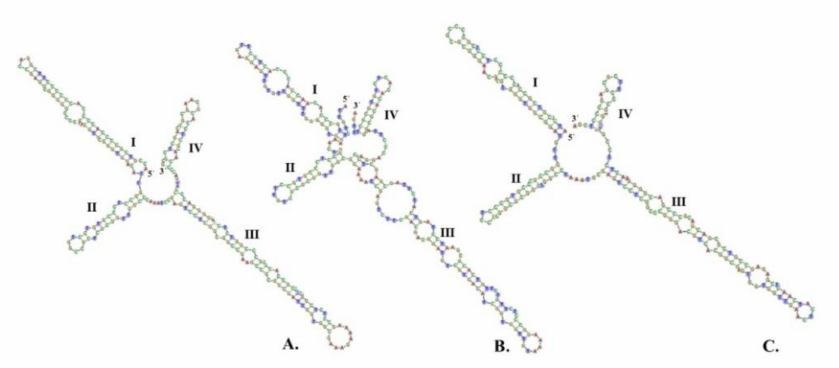
Figure 9. Predicted ITS2 secondary structure using Homology Modelling (HM) of ( A ) Aegle marmelos (L.) Corr ê a; ( B ) Coriander sativum L.; and ( C ) Morinda citrifolia L. as ingredients of the TS remedy. 2.6. Authentication of Crude Drugs of Aegle marmelos (L.) , Coriandrum sativum L. Corr ê a, and Morinda citrifolia